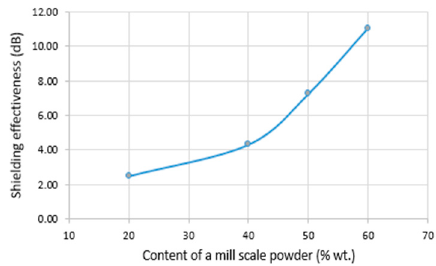
Figure 23. SE dependence of content of iron scale powder. Frequency—10 GHz.